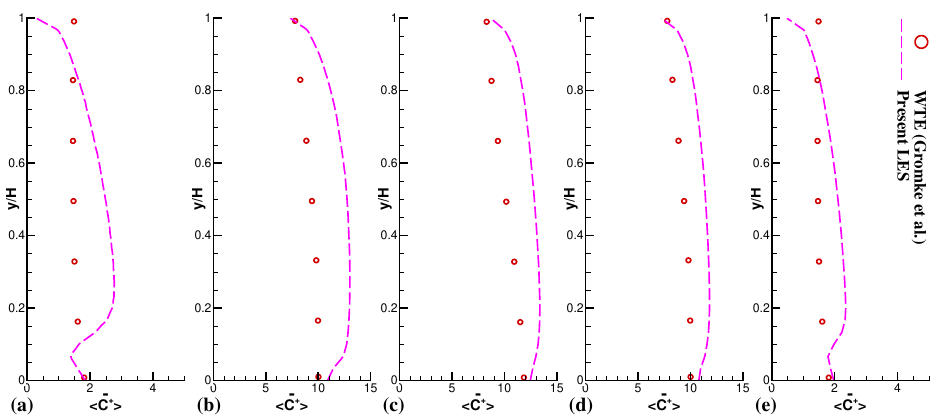
+ (cid:105) profiles at five separate spanwise